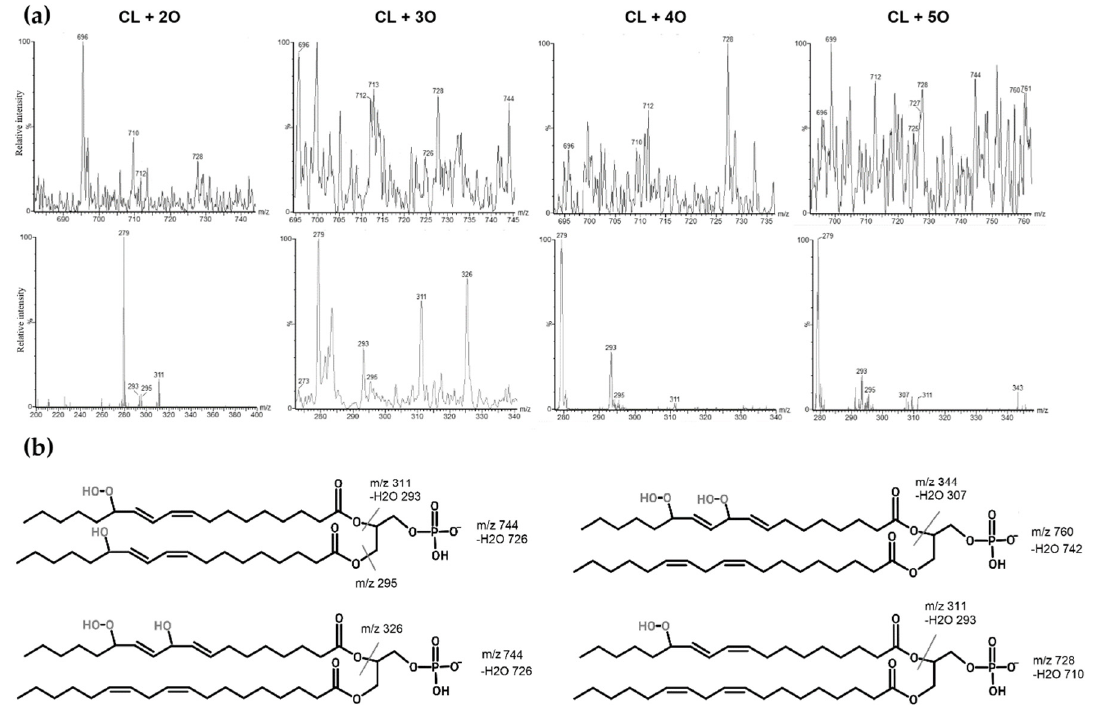
Figure 4. Mass spectra of oxidized tetralinoleoyl cardiolipin with an additional 2, 3, 4 and 5 oxygen atoms. ( a ) The oxidized phosphatidic acid fragments are shown in top mass spectra, and the oxidized linoleic acid fragments are shown in bottom mass spectra. ( b ) Several possibilities of oxidized tetralinoleoyl phosphatidic acid fragment structures are presented as well.